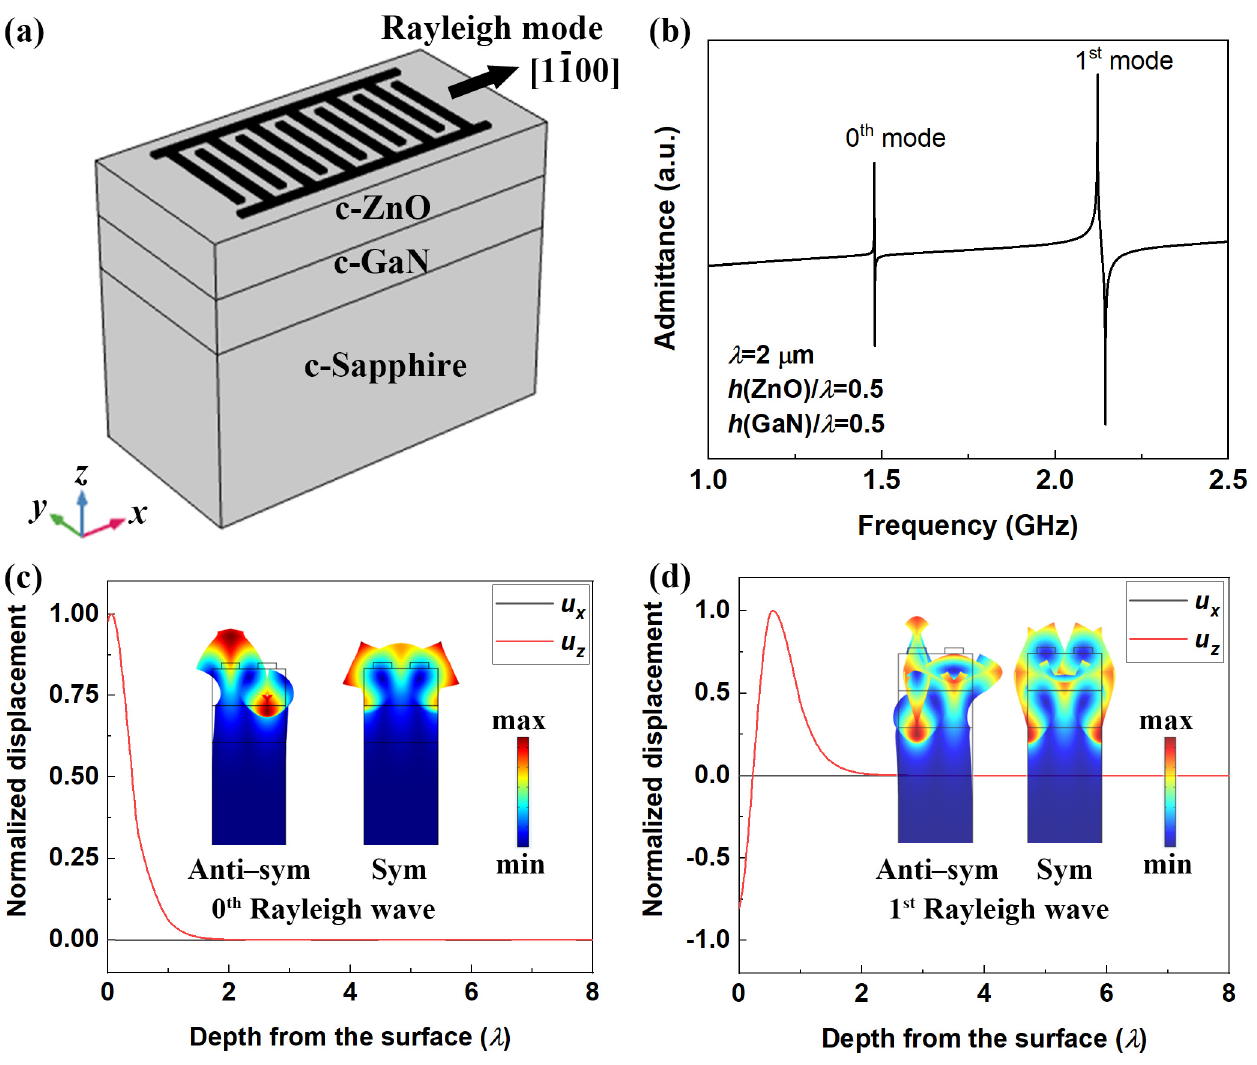
Figure 8. A typical admittance response ( b ) and its corresponding displacement curves and deformation shapes ( c , d ) of the SAW devices based on the c-ZnO/c-GaN/c-sapphire structure ( a ) where 0th Rayleigh-mode wave and 1st Rayleigh-mode wave (Sezawa-mode wave) are excited.